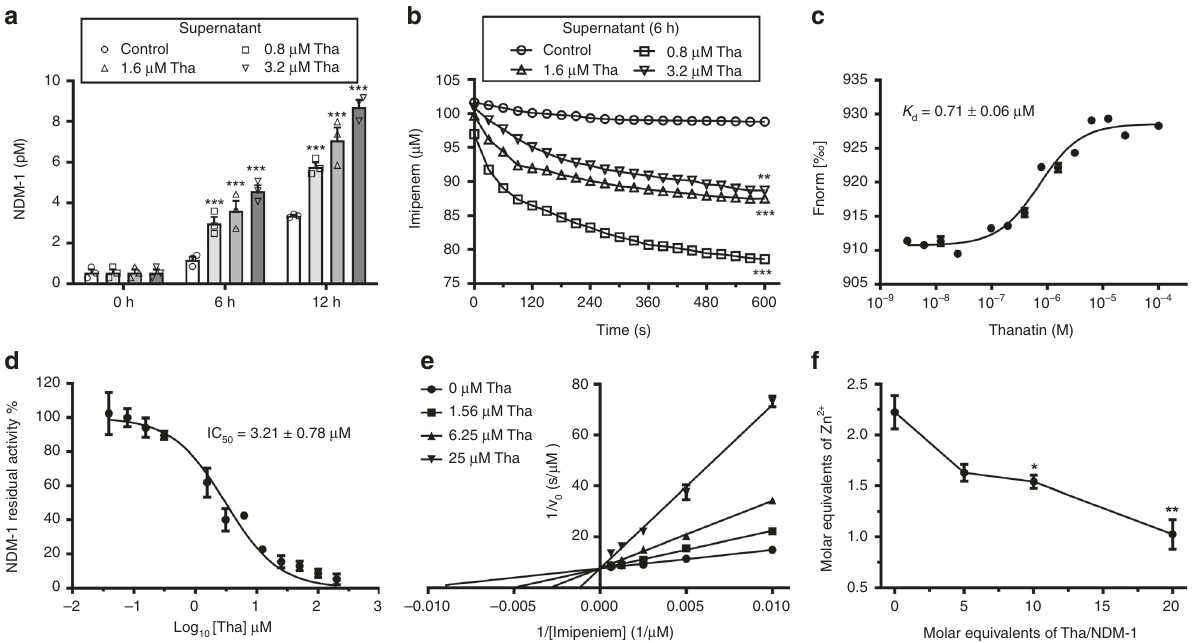
Fig. 5 Thanatin inactivates NDM-1. a Thanatin induced NDM-1 release to E. coli culture supernatant. b Hydrolytic effects of the supernatant on imipenem. The supernatant was obtained from thanatin-treated NDM-1-producing E. coli XJ141026 at 6 h. c K d value for binding of thanatin to RED-tris-NTA-labeled apo-NDM-1 was obtained by MST assay. d Thanatin inhibited the activity of NDM-1. e The Lineweaver – Burk plot. Thanatin is a competitive inhibitor of NDM-1. f Molar equivalents of zinc in holo-NDM-1 were detected by ICP-MS after thanatin treatment. Data are shown as the mean ± s.e.m. from three independent experiments. P- values were determined by two-way ANOVA ( a , b ), or one-way ANOVA with Bonferroni ’ s comparison test ( f ). * P < 0.05 ** P < 0.01, ** *P < 0.001 vs. control. Source data are provided in Source Data fi